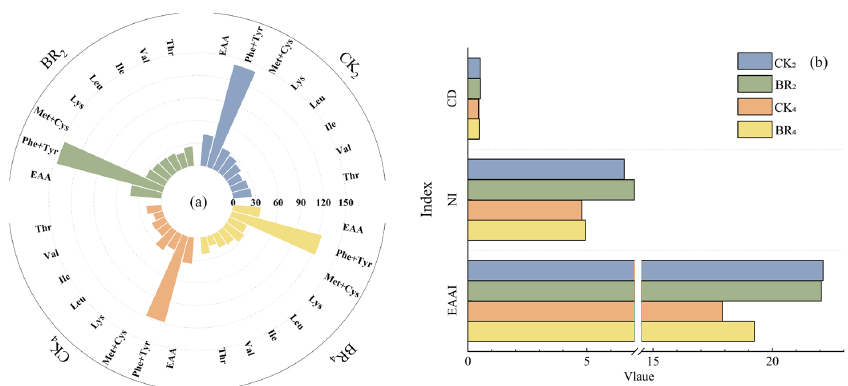
Figure 4. Nutritional quality of Ph. violascens shoots after sheath blade removal. ( a ): essential amino acids ( EAA s) of bamboo shoot proteins; ( b ): EAAI , NI , CD of bamboo shoot proteins; CK 2 : natural growth after 2 d; BR 2 : sheath blade removal after 2 d; CK 4 : natural growth after 4 d; BR 4 : sheath blade removal after 4 d.